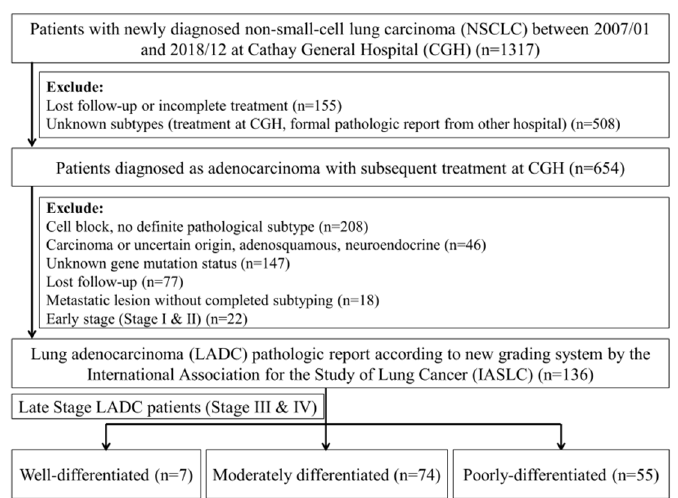
Figure 2. Histological patterns of lung adenocarcinoma. Representative hematoxylin and eosin- stained biopsy specimens: ( A ) lepidic-predominant pattern; ( B ) acinar-predominant pattern; ( C ) papillary-predominant pattern; ( D ) solid-predominant pattern; and ( E ) micropapillary-predomi- nant pattern. The authors apologize for any inconvenience caused and state that the scientific con- clusions are unaffected. The original article has been updated. Funding: This research received no external funding. Conflicts of Interest: The authors declare no conflict of interest. Reference 1. Weng, C.-F.; Huang, C.-J.; Huang, S.-H.; Wu, M.-H.; Tseng, A.H.; Sung, Y.-C.; Lee, H.H.-C.; Ling, T.-Y. New International As- sociation for the Study of Lung Cancer (IASLC) Pathology Committee Grading System for the Prognostic Outcome of Advanced Lung Adenocarcinoma. Cancers 2020 , 12 , 3426, doi:10.3390/cancers12113426.